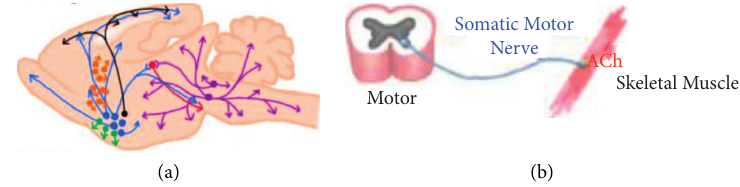
Figure 2: (a) ACh in central nervous systems shown as orange and green cell clusters, limbic structures in blue, and cholinergic projection represented by the black pathway; (b) ACh in the peripheral nervous system (picture adapted from https://nba.uth.tmc.edu/neuroscience/ m/s1/chapter11.html).